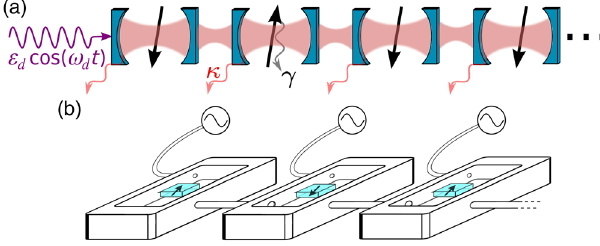
FIG. 1. (a) One-dimensional array of cavity-qubit systems coupled by photon exchange and subject to one or several ac microwave drives, cavity decay at rate κ , qubit relaxation γ , and pure dephasing γ ϕ . (b) Implementation with superconducting transmon qubits embedded in interconnected microwave cavities and driven by external continuous-wave